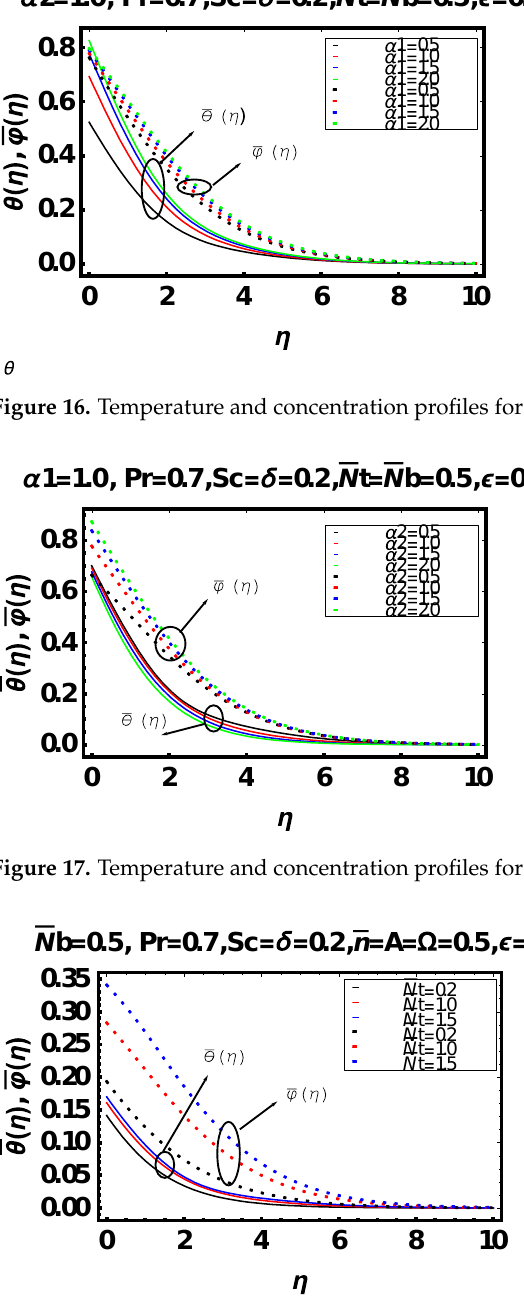
Figure 18. Temperature and concentration profiles for variant N t